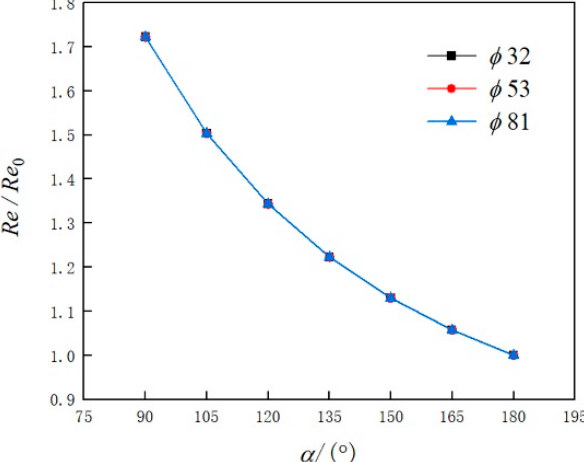
Figure 9. Relative Reynolds number Re / Re 0 changing with the central angle α for helical pipes.